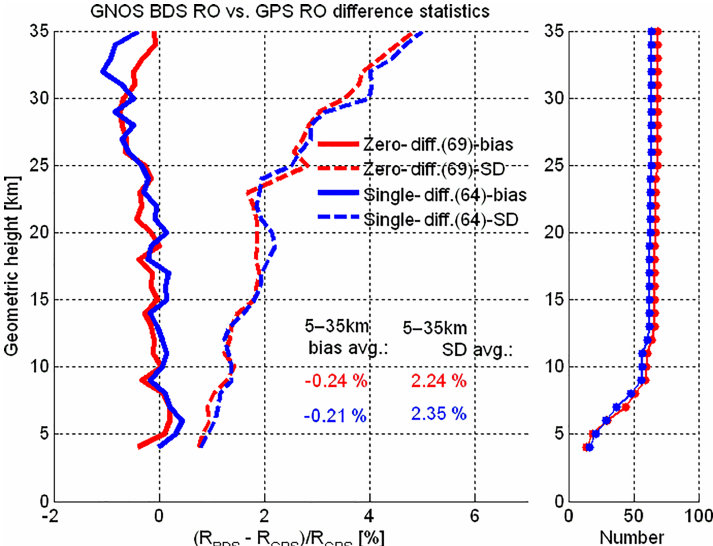
Figure 6. Mean difference (bias) and standard deviation (SD) statistics of GNOS-derived refractivity ( R ) profiles retrieved based on the zero differencing (red) and single differencing (blue) methods, from an ensemble of BDS RO profiles collocated with GPS RO profiles ( ± 200km/ ± 1h collocation criterion; outlier quality control with maximum of 8% deviation to ECMWF within 5–35km, leading to slightly more collocations for the zero differencing data). Bias (solid) and SD (dashed) profiles as well as the number-of-event profiles (small panel on the right) are shown. The legend indicates the average bias and SD values within